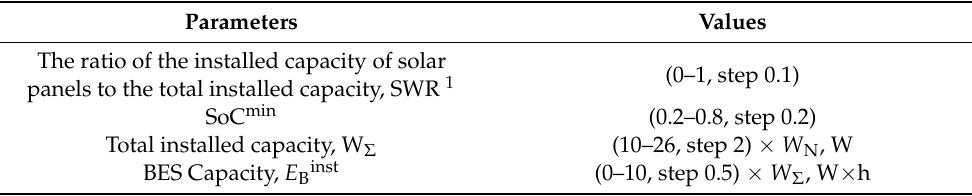
Table 2. Power system parameters.